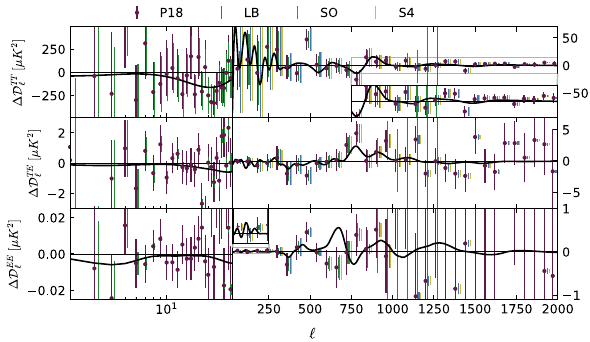
Fig. 4 Residual plots for our best fit candidate. P18 data points and error bars are plotted in purple, whereas the forecast error bars for Lite- BIRD,SOandCMB-S4areplottedingreen,blueandgold,respectively. Errors for (cid:2) > 30 are binned with binwidth (cid:10)(cid:2) =